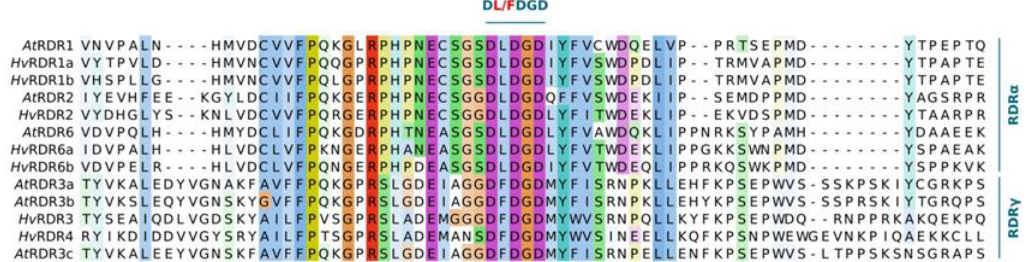
Figure 7. Presence of functionally critical amino acid residues in barley RDR proteins. Catalytic domain within RdRP is shown. For full-length alignment of RDRs see Figure S3.